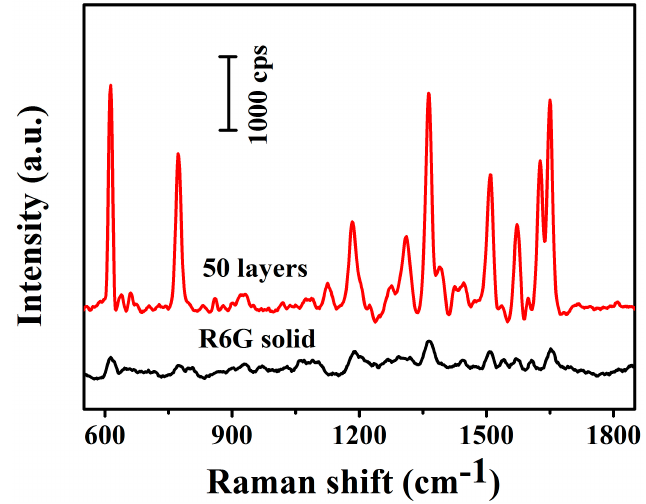
Figure 11. ( a ) Raman spectra of R6G molecules with 10 -3 M concentration from the different layers film substrates. ( b ) SERS spectra of MB obtained on 36 random locations from 6 different MXene- SO3H/MB-50 film substrates. ( c and e ) Raman mapping image at 1396 and 1629 cm -1 of MB molecules with cover the area of 6 × 6 μ m 2 of the MXene-SO3H/MB-50 film substrate. ( d and f ) The corresponding bar plot of Raman intensity at 1396 and 1629 cm -1 in the above detection area of MXene- SO3H/MB-50 film substrate.